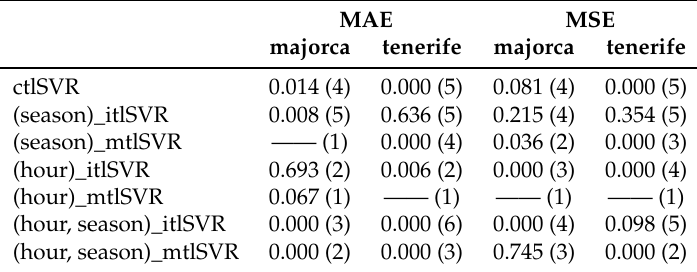
Table 4. Wilcoxon p -values for absolute (left) and quadratic (right)